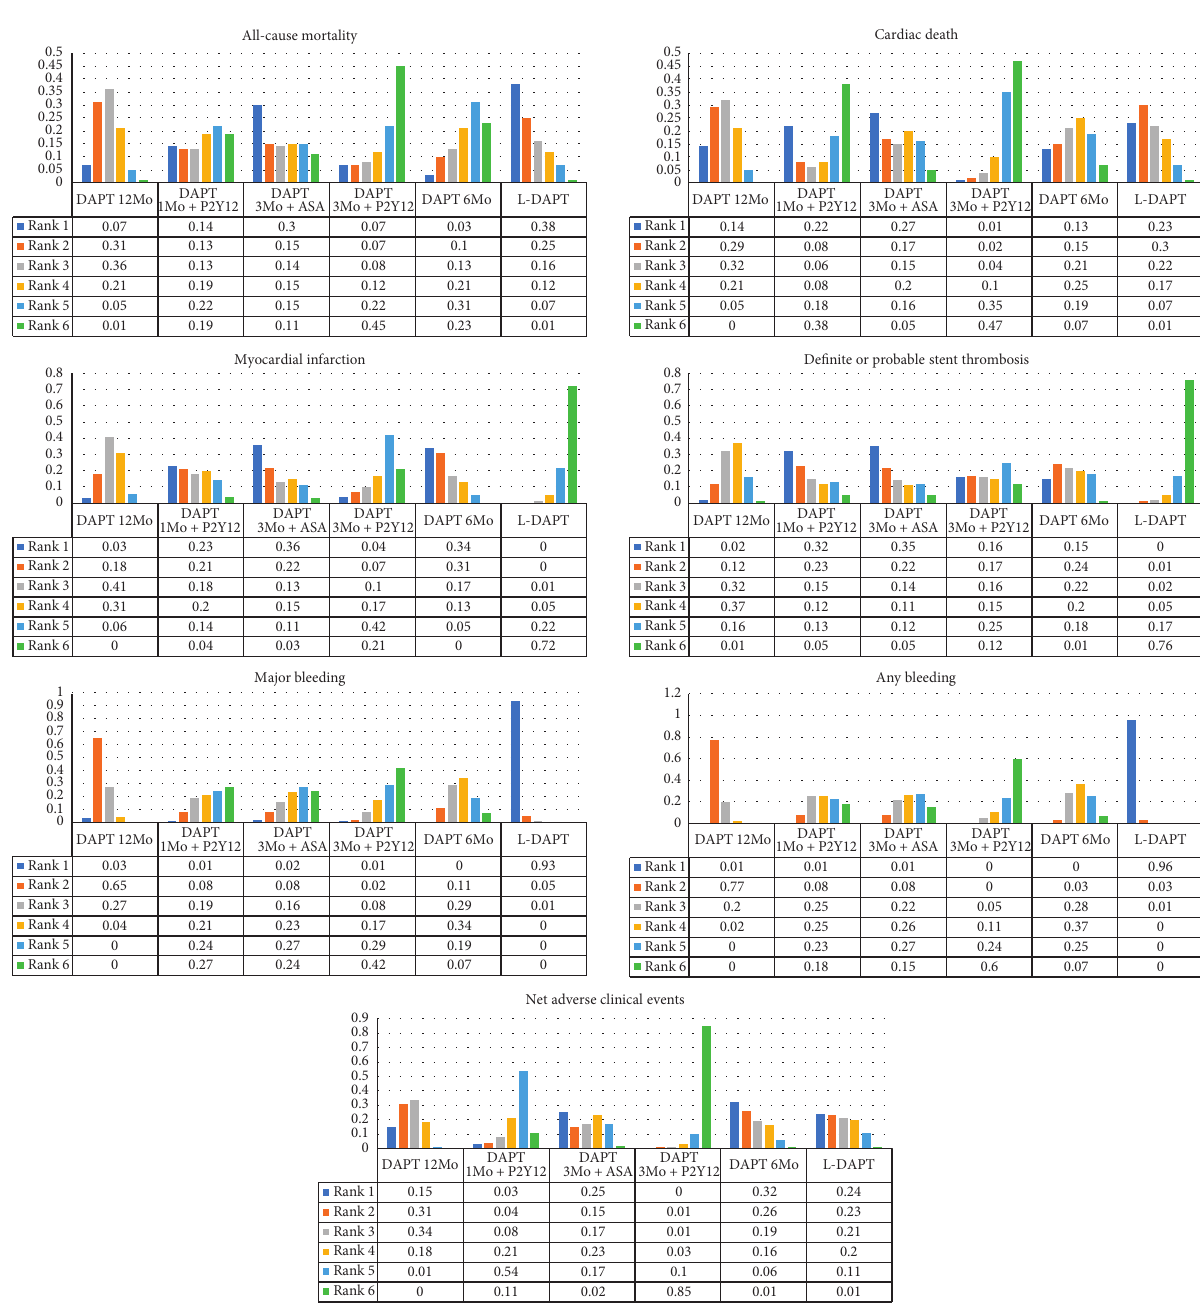
Figure 4: Rankograms for each endpoint. Rank 1 is the worst and rank 6 is best. L-DAPTrefers to longer-term ( > 12 months) DAPT, DAPT 12Mo refers to 12-month DAPT, DAPT 6Mo refers to 6-month DAPT, DAPT 3Mo +ASA refers to 3-month DAPT followed by aspirin monotherapy, DAPT 3Mo +P2Y12 refers to 3-month DAPTfollowed by P2Y12 receptor inhibitor monotherapy, and DAPT1Mo +P2Y12 refers to 1-month DAPT followed by P2Y12 receptor inhibitor monotherapy. DAPT indicates dual antiplatelet therapy. (a) All-cause mortality. (b) Cardiac death. (c) Myocardial infarction. (d) Definite or probable stent thrombosis. (e) Major bleeding. (f) Any bleeding. (g) Net adverse clinical